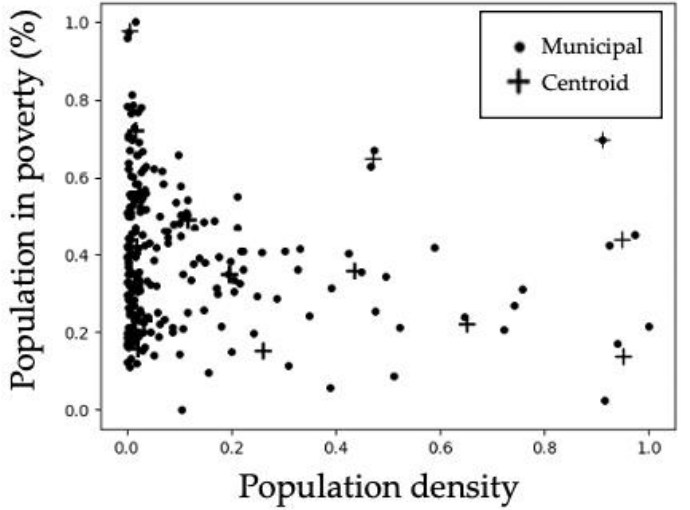
Figure 3. Distribution of centroids into clusters.